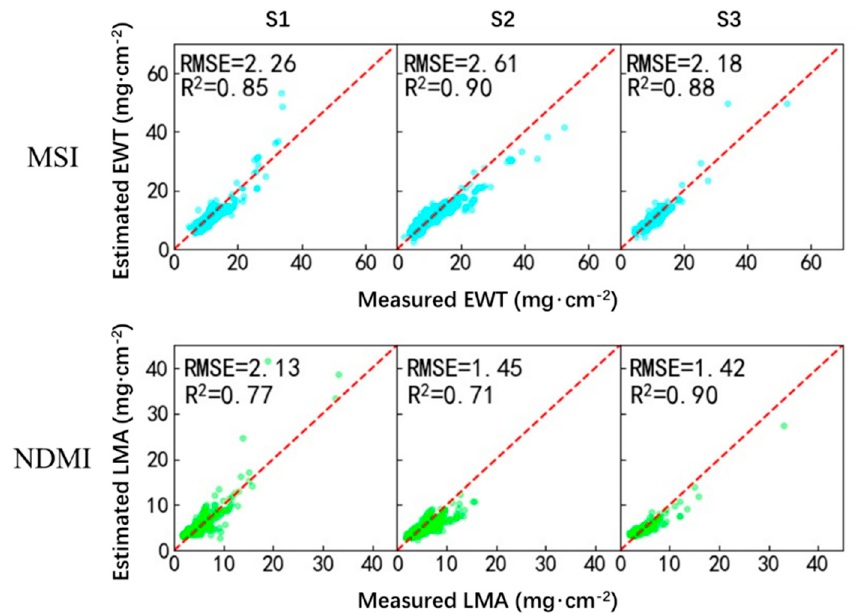
Figure 2. Validation of the moisture stress index (MSI)-based and normalized dry matter index (NDMI)-based models for the estimation of EWT and LMA.